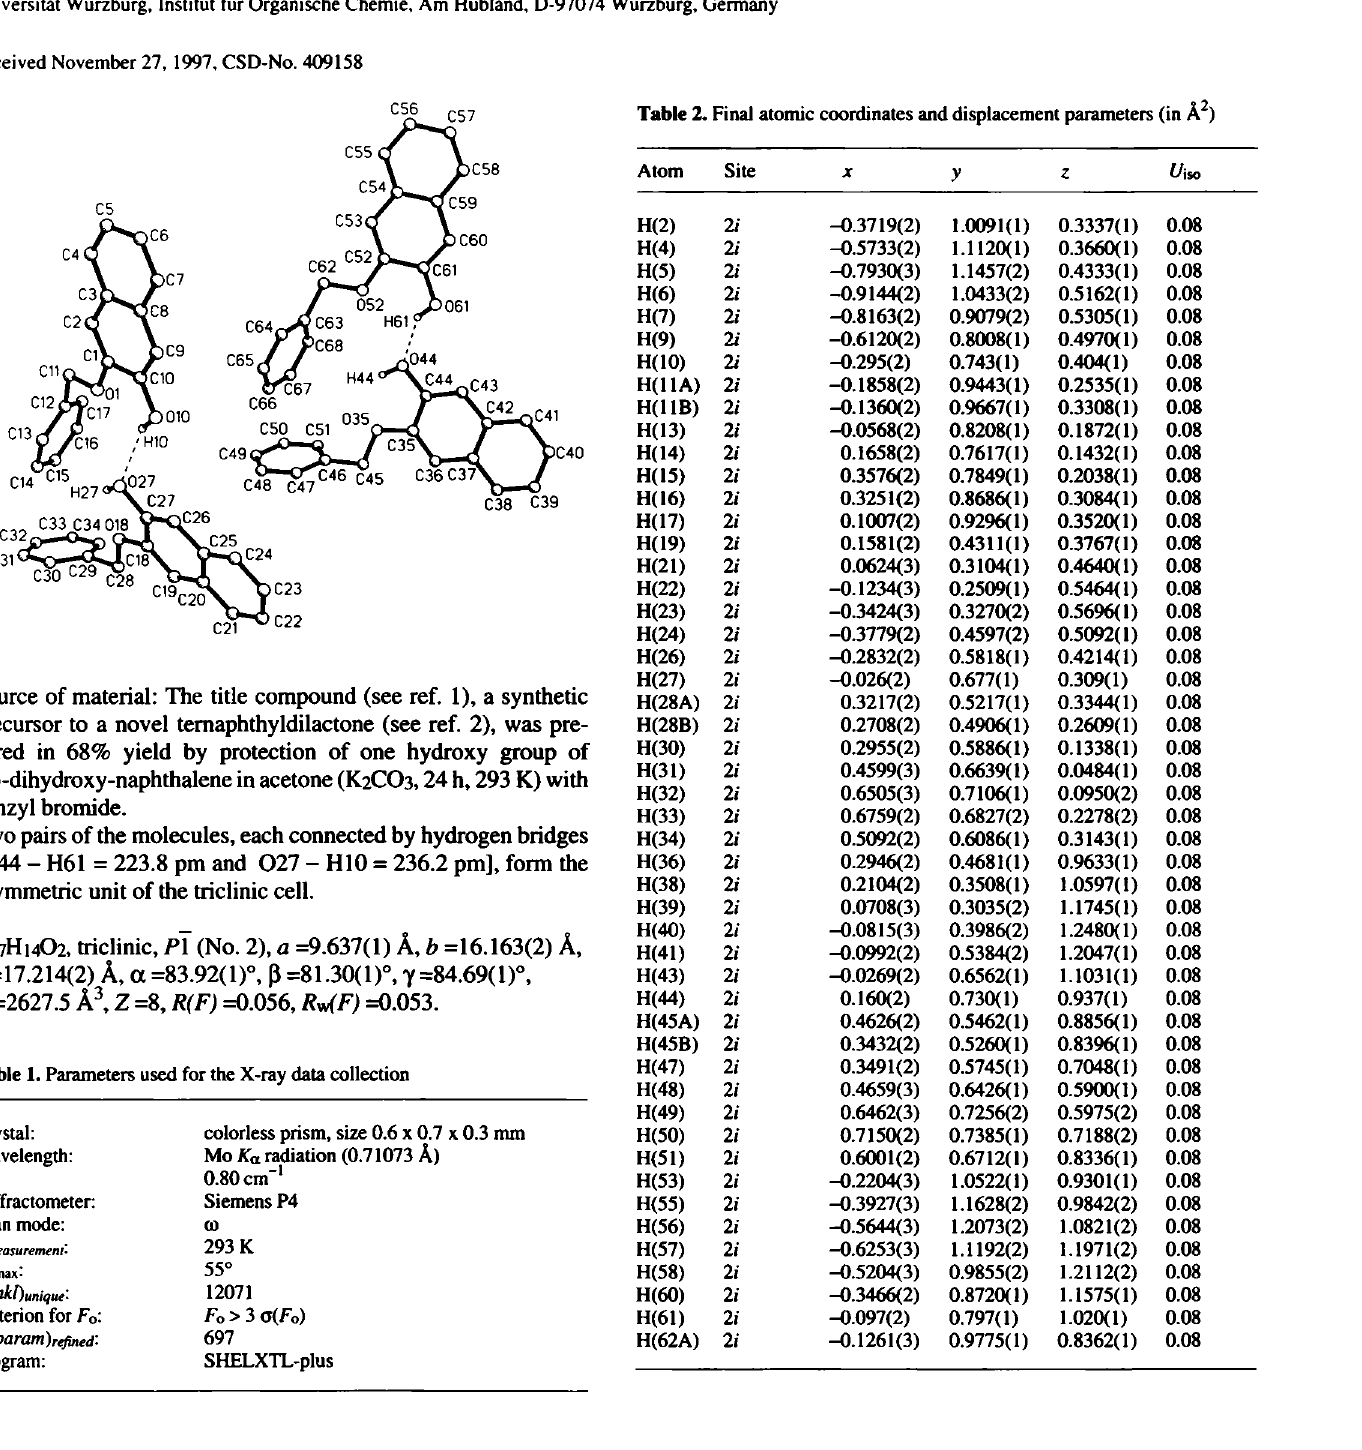
Table 2. Final atomic coordinates and displacement parameters (in Â^)